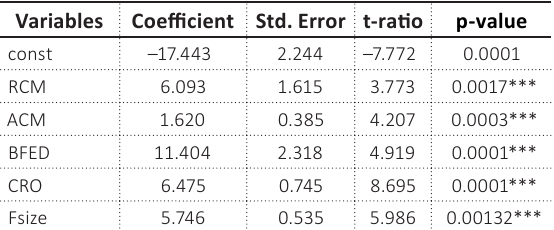
Table 4. Regression estimates for model 1: fixed effects